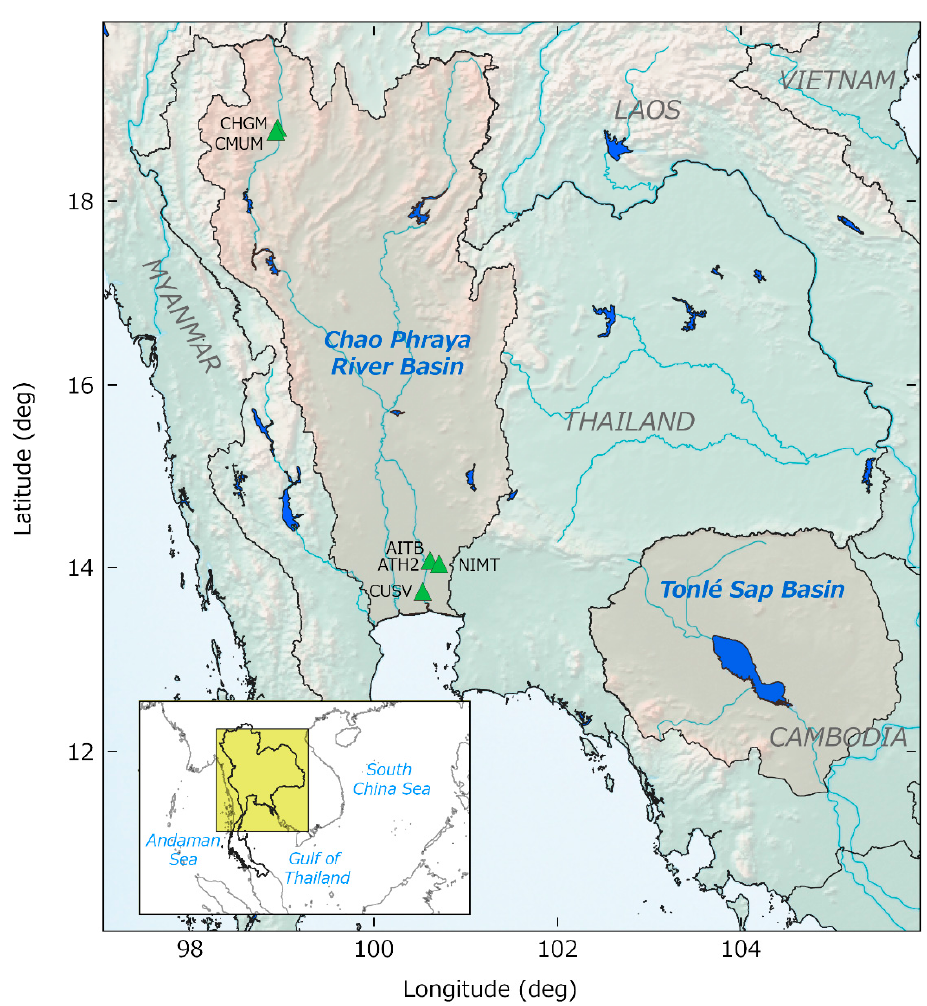
Figure 1. The Central South-East Asia (CSEA) region encompassing two major river basins, i.e., the Chao Phraya River and Tonlé Sap Basins. The locations of six available Global Positioning System (GPS) sites are shown as green triangles. Characteristics of GPS sites can be found in Table 1.